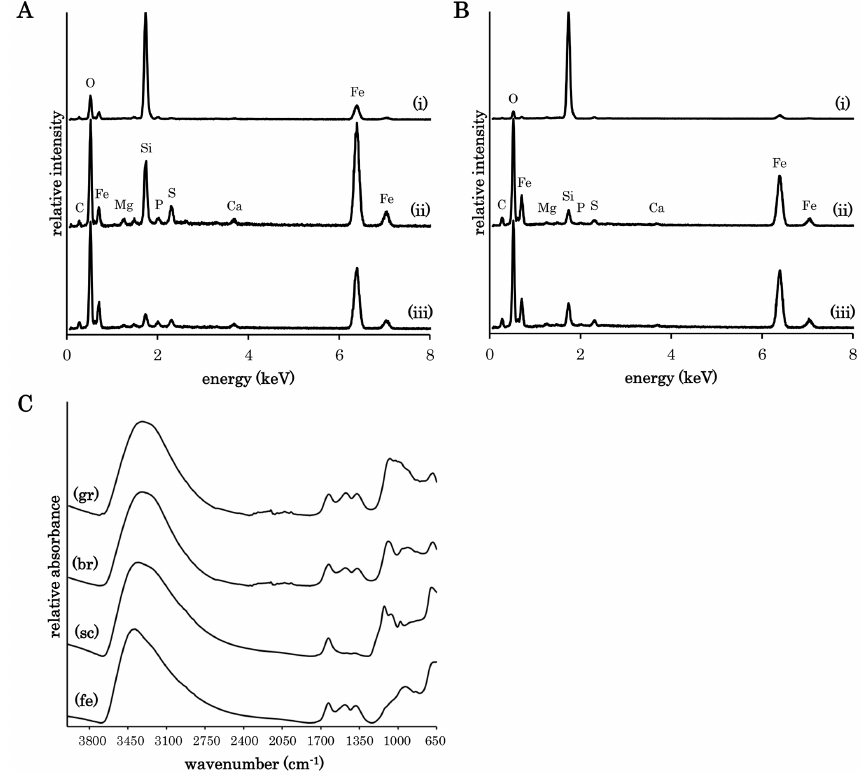
Figure 6. EDX and FTIR spectra of minerals precipitated around the algae. EDX spectra of minerals around the green algae (a) and the brown algae (b) were recorded on the non-encrusted algal surface (i), the encrusted algal surface (ii) and Fe-oxides which were not connected to the algae (iii). FTIR spectra of Fe-oxides (c) were recorded on the green algae (gr) and the brown algae (br), when compared with spectra of schwertmannite (sc) and ferrihydrite (fe) as